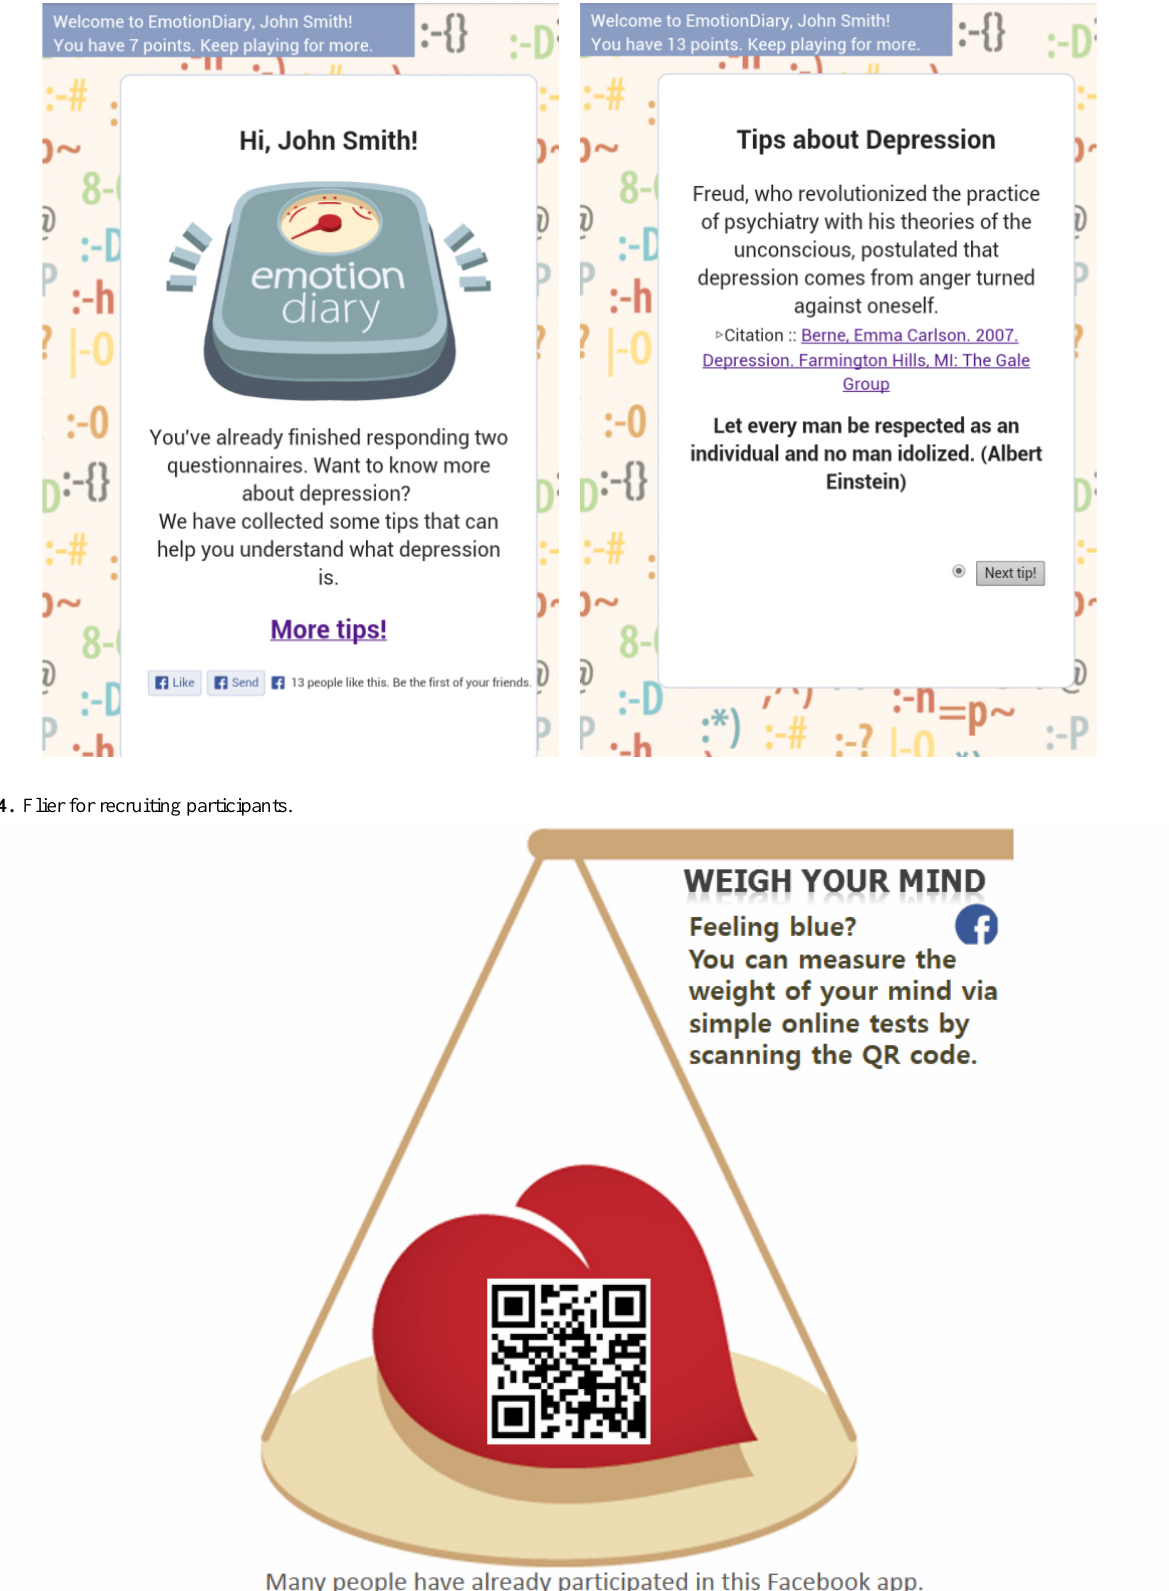
Figure 3. EmotionDiary screenshots: depression tips and facts.